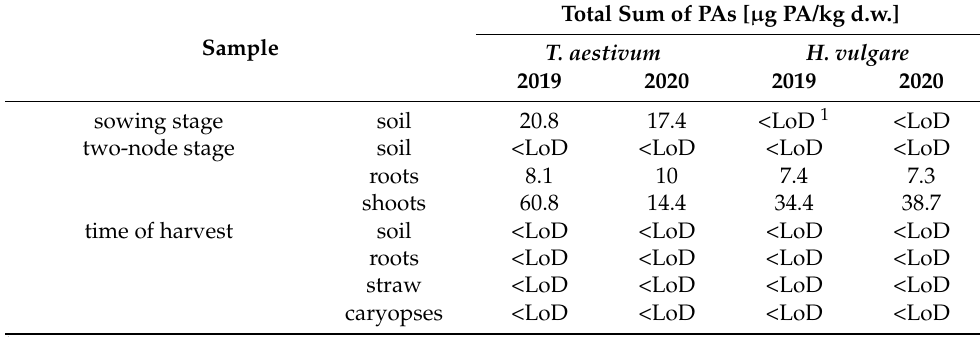
Table 3. PA-content of follow-up crops ( T. aestivum and H. vulgare ) on plots used for the cultivation of L. squarrosa the year before. Total Sum of PAs [ µ g PA/kg d.w.] Sample T. aestivum H.